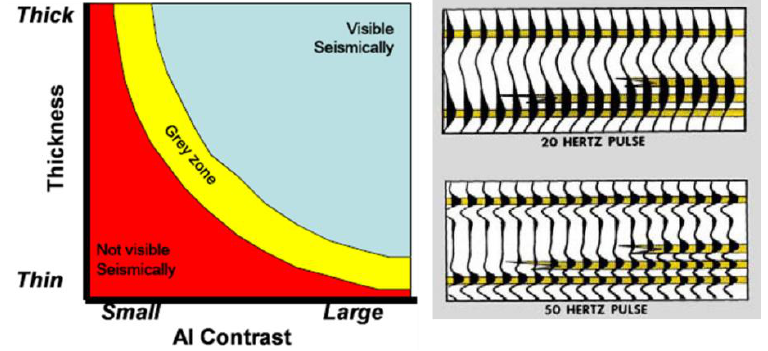
Figure 1—Some of the key variables that affect seismic detectability.